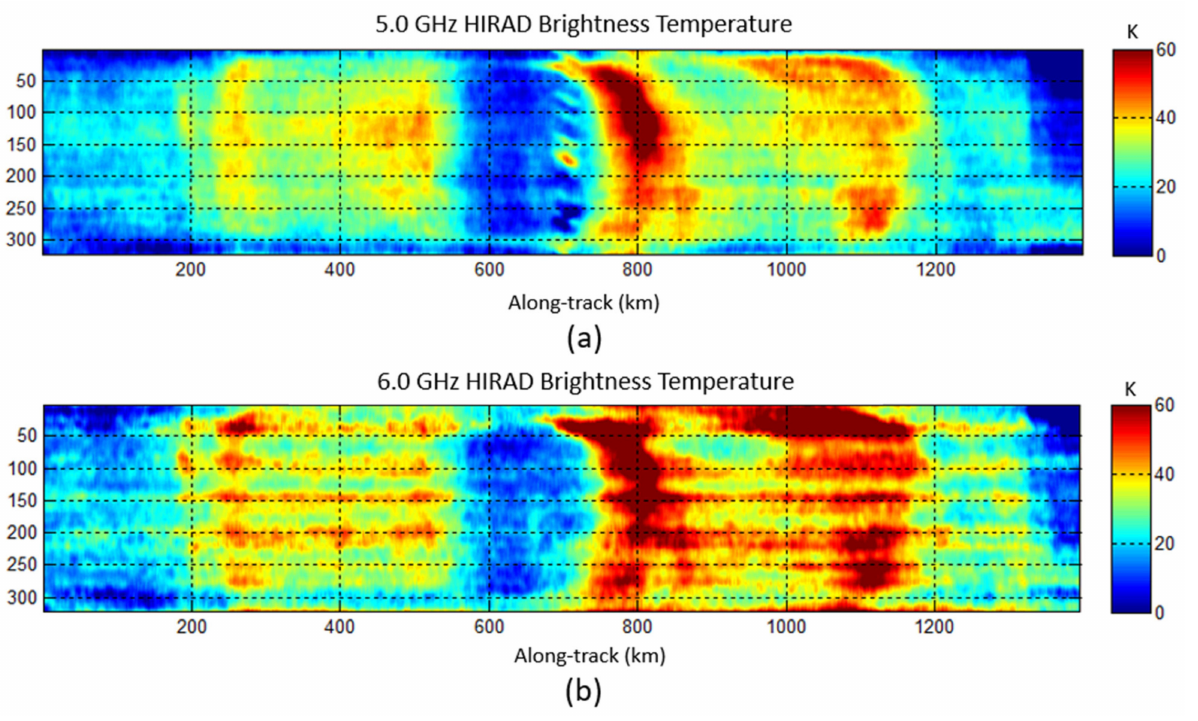
Figure 3. MSFC externally calibrated excess T B for Hurricane Gonzalo Leg 4 for ( a ) 5.0 GHz and ( b ) 6.0